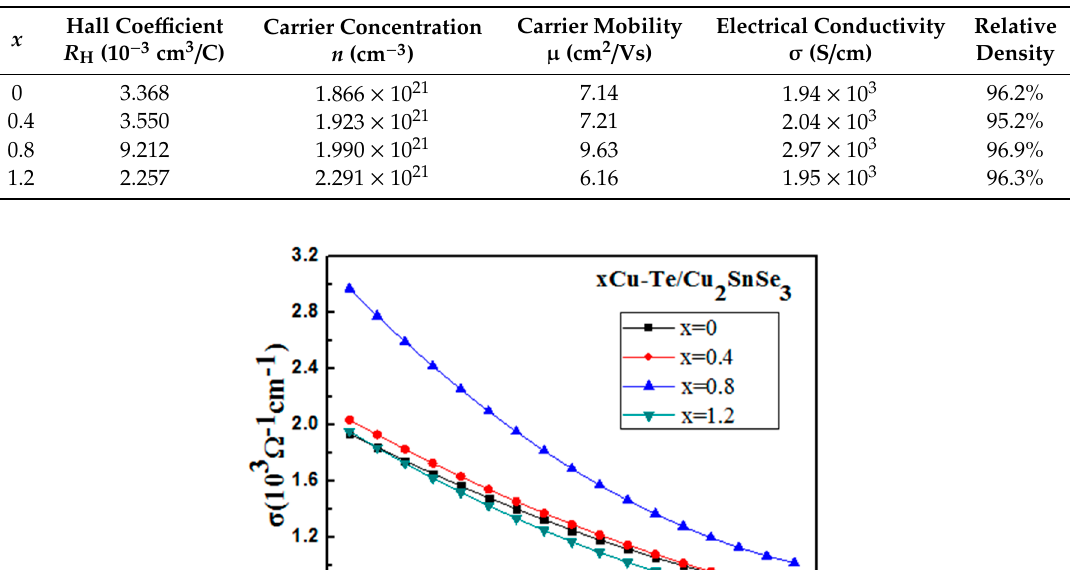
Figure 8. Temperature dependence of the power factor (PF) of Cu–Te/Cu 2 SnSe 3 composites. 3.3. Thermal Transport Properties Figure 9 shows the temperature dependence of total thermal conductivity κ and lattice thermal conductivity κ L for Cu–Te/Cu 2 SnSe 3 composites. It can be seen that the addition of melt-spun Cu–Te decreased the κ and κ L of Cu 2 SnSe 3 thermoelectric material evidently. It is already reported that the micro-voids/nanopores or holey structures can suppress the average group velocities at low temperatures and this suppression is expected to intensify as the temperature increases. Therefore, the micro-voids/nanopores in Cu–Te/Cu 2 SnSe 3 could potentially introduce additional phonon scattering and play a great role in reducing the κ L by targeting long-wavelength phonon scattering. However, there was little difference in κ among the Cu–Te/Cu 2 SnSe 3 composites in the whole temperature range. The κ is composed of κ L and carrier thermal conductivity ( κ c ). The κ c can be estimated using the Wiedemann–Franz law, κ c = L σ T , where L is the Lorenz constant and has a value of 2.45 × 10 − 8 V 2 /K 2 [20,21]. The κ L can be calculated by subtracting the κ c from κ . As the 0.8 vol.% Cu–Te/Cu 2 SnSe 3 composite had a large κ c , κ L of the 0.8 vol.% Cu–Te/Cu 2 SnSe 3 was minimal and ~0.22 − 1.1 W/m·K. The minimum κ L of 0.8 vol.% Cu–Te/Cu 2 SnSe 3 was 0.22 W·m − 1 ·K − 1 at 700 K, which was 78% lower than that of the Cu 2 SnSe 3 matrix. In addition, κ L showed temperature dependence of T − 1 in the whole temperature range, suggesting that phonon–phonon scattering dominated the scattering mechanism for the Cu–Te/Cu 2 SnSe 3 composites.